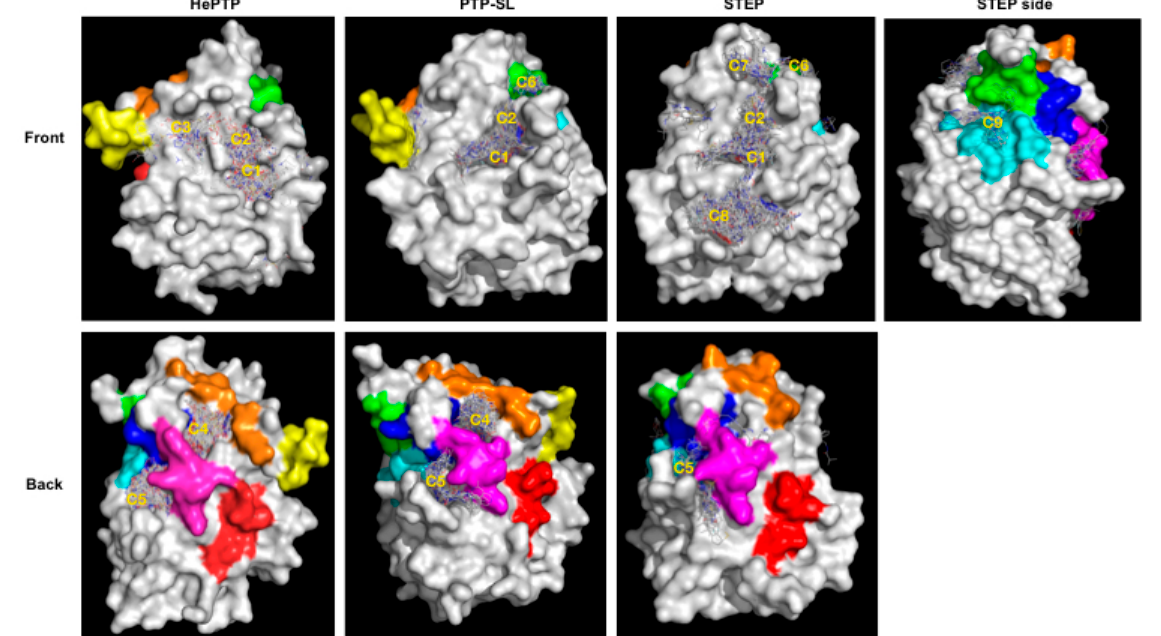
Figure 1. Blind docking results for kinase interaction motif protein tyrosine phosphatases KIM-PTPs (HePTP, PTPSL and STEP). The structure of the three KIM-PTPs are shown as a grey surface with key functional KIM-PTP specific motifs [33] coloured as follows: K2 in yellow, K3 in orange, K4 in red, K5 in magenta, K6 in cyan, K7 in blue, K8 in green. Compounds are shown as lines. Areas where there is a high density of compounds (greater than 10) are classified as clusters and numbered: C1, active site; C2, open form pocket; C3, substrate-binding site; C4, centred between K3, K5 and K7; and C5, centred on K5, K6 and K7; C6, centred on K8; C7 above open pocket; and C8 below the active site. The front view and back view for all three KIM-PTPs are shown. For STEP, a side view is also shown to see cluster C9 on K6.